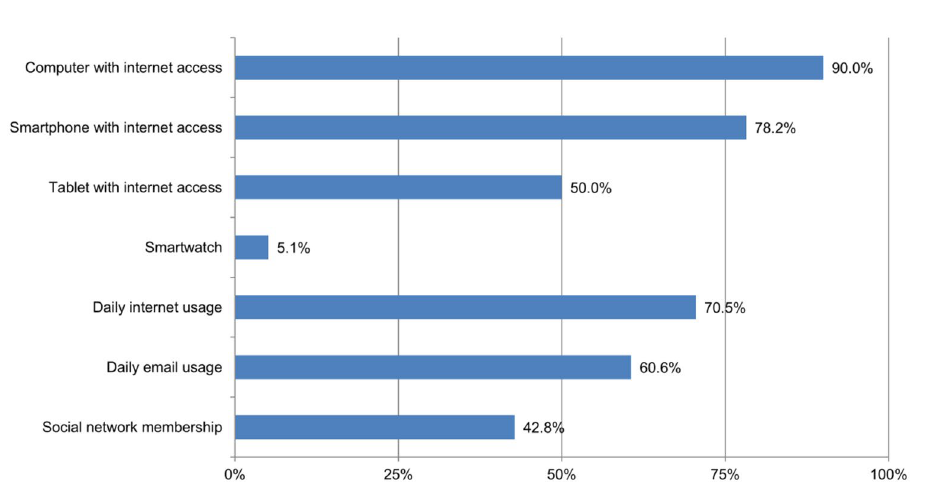
Figure 1. Penetration and present use of modern ICT in solid organ transplant recipients in % (answers given by the 234